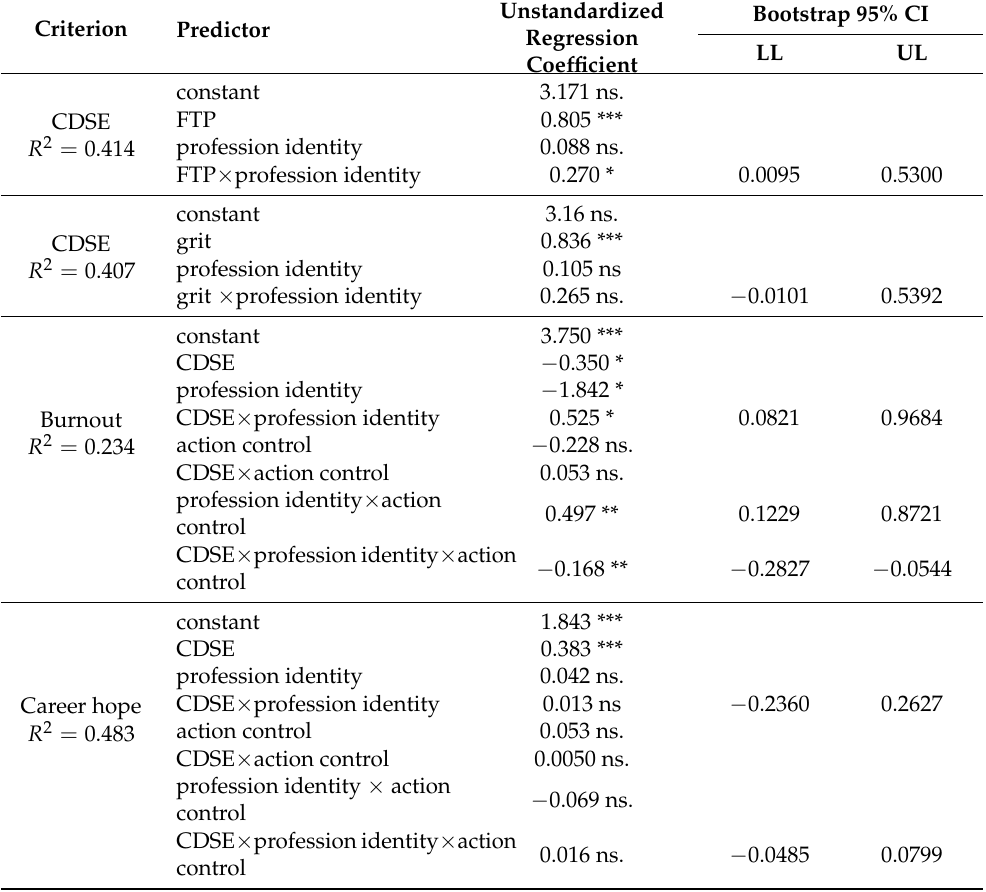
Table 4. Moderated-moderation regression coefficients and confidence